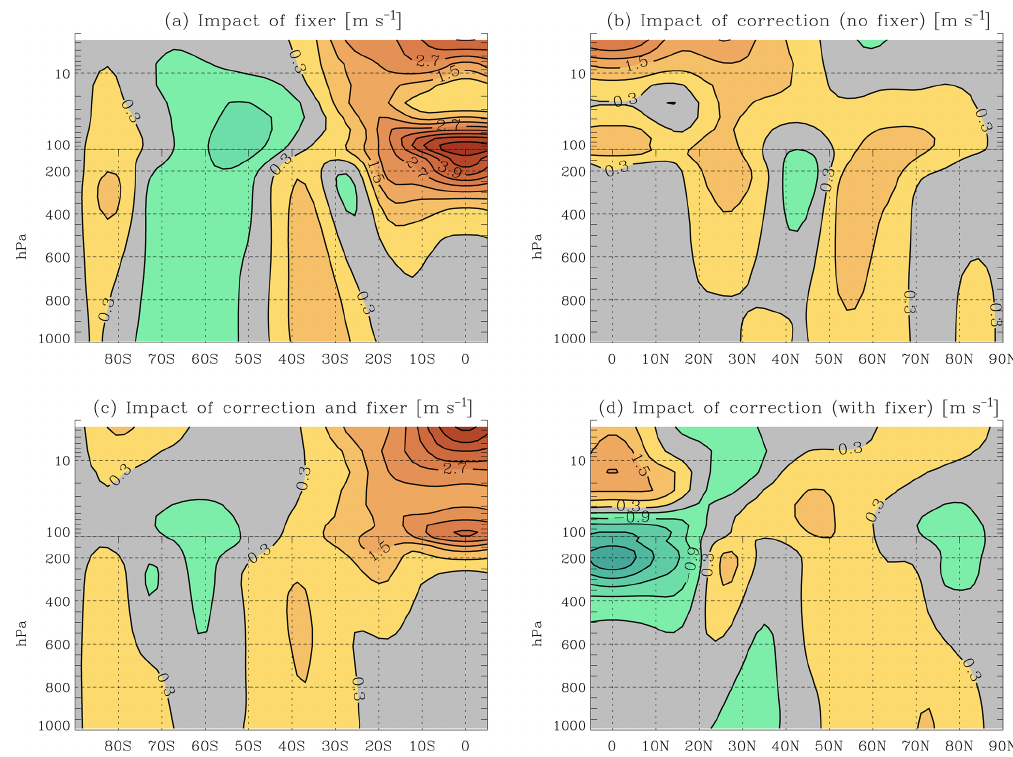
Figure 7. Impact of the AM correction and fixer in Held–Suarez simulations. Time-mean latitude–pressure profiles of wind differences between HS simulations shown in the stippled lines in Fig. 6. Panel (a) shows the zonal-mean zonal-wind time-average (days 120–360) difference field of the integration with the AM fixer only and the control integration. Panel (b) shows the same field, but for the difference between the integration with the AM correction and control. Panel (c) shows the difference between the integration with both the AM correction and AM fixer and control; (d) the difference between the integration with both the AM correction and AM fixer and the integration with the AM fixer only. The contour interval is 0.6ms − 1 , with blue hues indicating negative values and red hues positive values. Values in the interval [ − 0 . 3, + 0 . 3]ms − 1 are left in grey. The fields displayed have been symmetrised about the Equator, since departures from symmetry are very small in the time mean for these hemispherically symmetric simulations. Accordingly, only one hemisphere and the equatorial region are shown in each